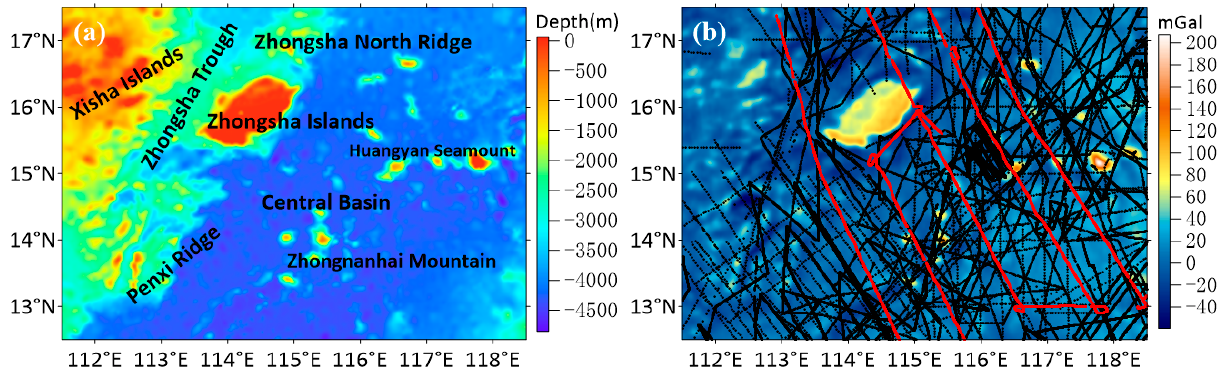
Figure 1. Overview and experimental data of the research area: ( a ) overview of the study area with the ETOPO1 model in the background and ( b ) the gravity anomaly derived via satellite altimetry; the black dots in the figure are the control data and the red dots are the check data. Table 1. Statistical results of the experimental